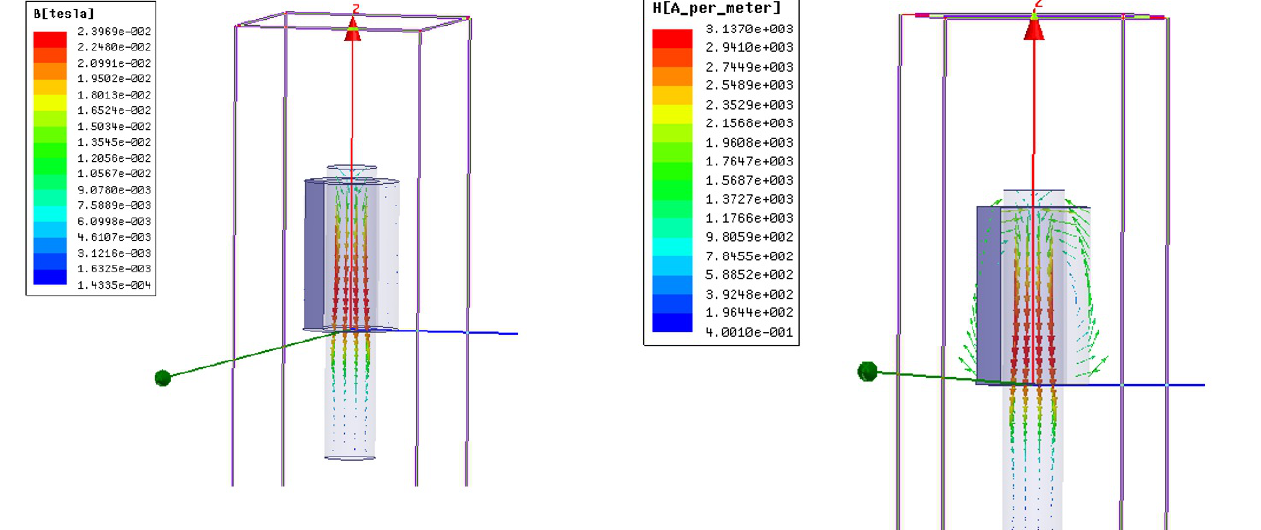
Fig. 6. Magnetic induction intensity distribution.